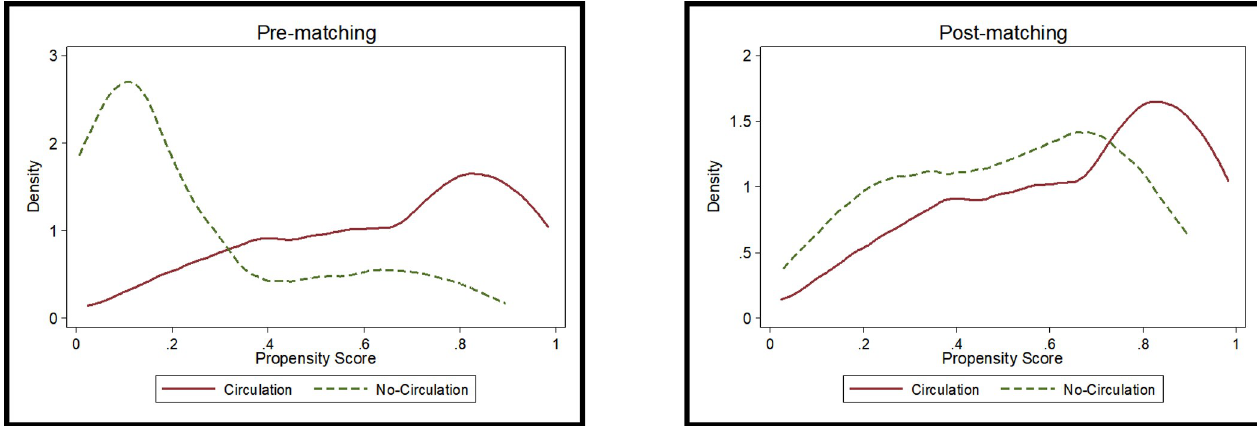
Fig 1. Probability distribution of propensity score nucleus before and after matching. (a) Probability distribution of propensity score nucleus before matching. (b) Probability distribution of propensity score nucleus after matching.